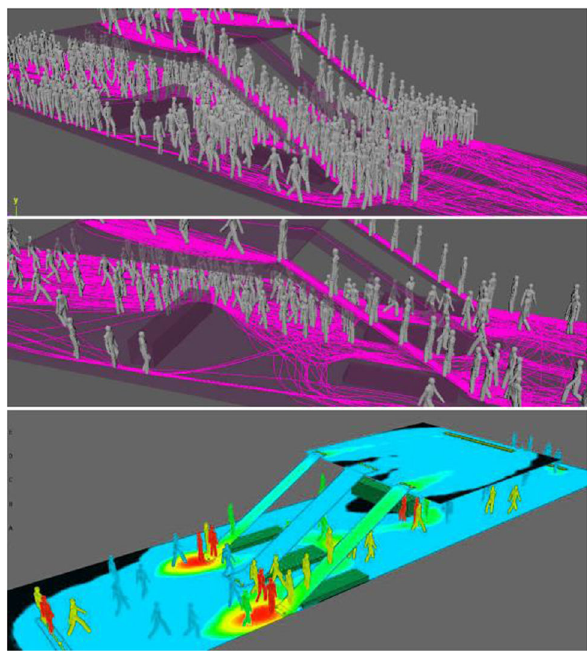
Fig. 3 Path visualization with curve and heat map. By Ming